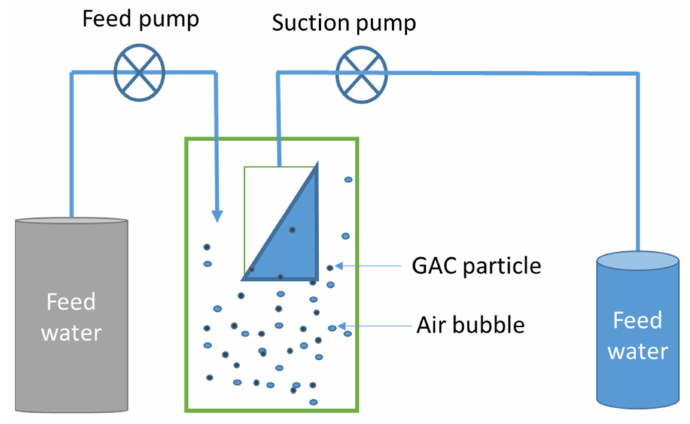
Figure 2. MF-GAC hybrid system (GAC initial dose of 2